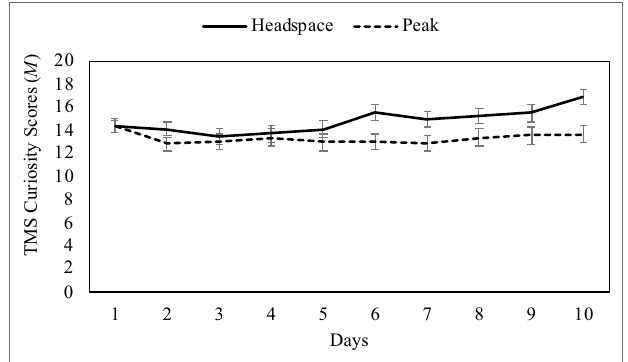
FIGURE 1 | Mean TMS curiosity scores by intervention day and condition, with ±1 standard error bars.